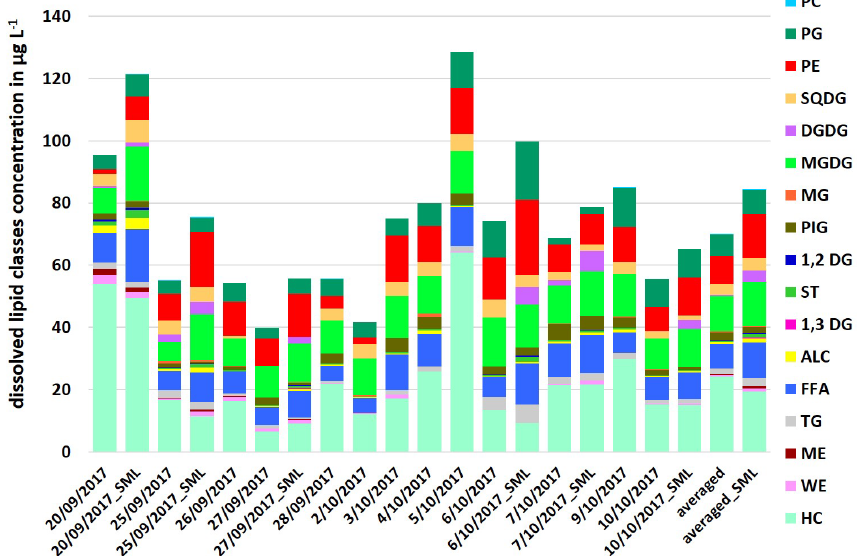
Figure 2. Concentration of individual dissolved lipid classes in the ULW (sampling date) and the SML (sampling date_SML) samples along the campaign and as an averaged value in µgL − 1